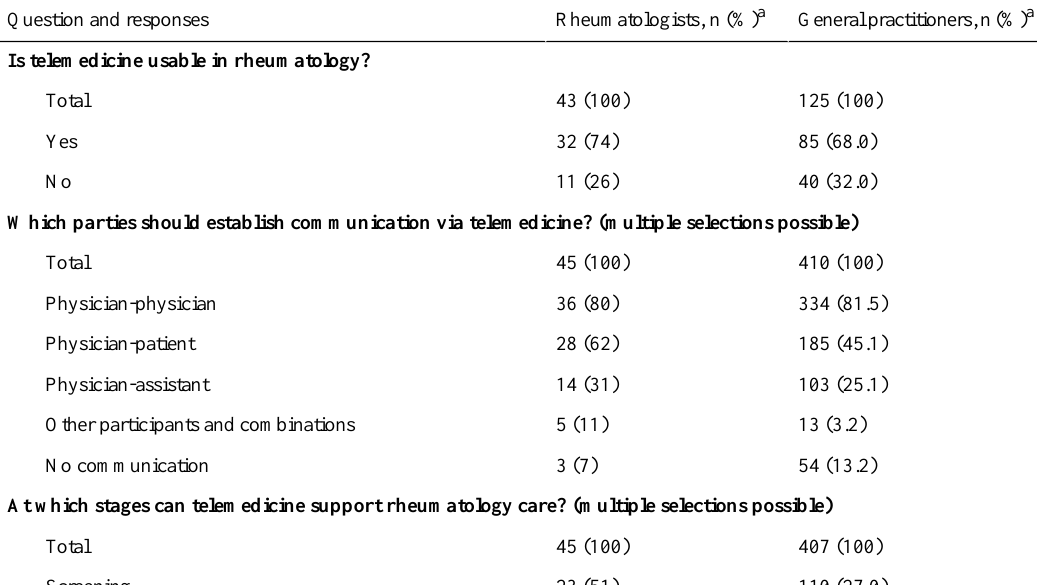
Is telemedicine usable in